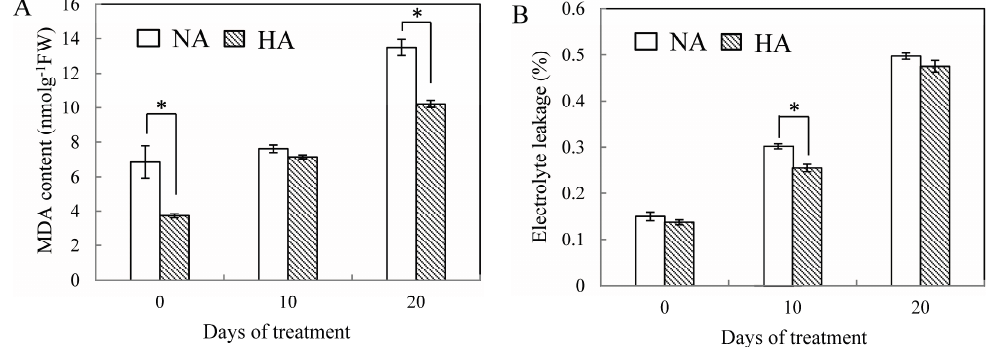
Figure 2. Effects of heat stress on the content of MDA ( A ) and electrolyte leakage (EL) ( B ) in leaves of both heat-acclimated (HA) and non-acclimated (NA) plants. Error bars represent standard error of the mean. Asterisks above columns indicate a significant treatment difference between HA and NA, LSD ( p ≤